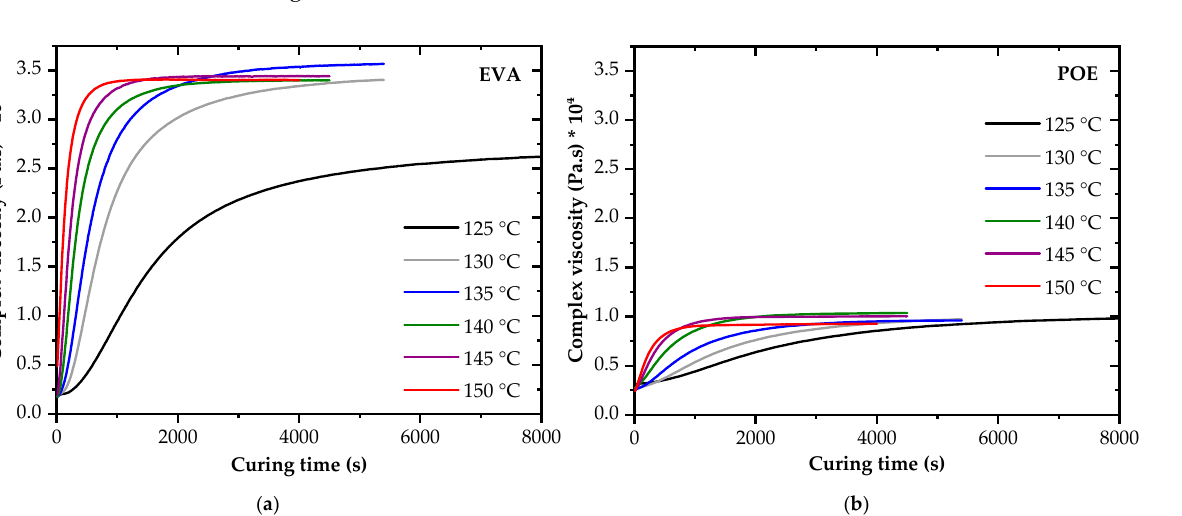
Figure 4. Arrhenius plots and activation energy for EVA and POE encapsulants. To assess and describe the progress of the curing reaction as a function of time, the complex viscosity ( η * ) was evaluated. In Figure 5, the complex viscosity of EVA and POE is plotted for different temperatures. While the increase in the complex viscosity is related to the curing reaction, the leveling off indicates the completion of the crosslinking. The shape of the complex viscosity curves was almost similar for the EVA and POE encapsulants. However, a factor of more than four higher complex viscosity values were obtained for EVA in the cured state. This is in agreement with the results of the temperature-rise DMA. Presumably, the higher viscosity in the cured state of EVA could be attributed to the higher amount of tertiary carbon atoms, the denser crosslinking structure and the higher gel content. The initial complex viscosity values were at a comparable level. The rate of decomposition of the peroxides and the curing reactions were much faster at higher temperatures. Hence, the shear modulus and complex viscosity curves were shifted to shorter curing times at higher temperatures. A comparison of the complex viscosity data of the investigated UV-transparent EVA grade with values reported in [20,24] again revealed a good agreement in the non-crosslinked state and slightly higher values for the cured elastomer. Presumably, the attainable gel content was lower for the UV-transparent EVA grade.